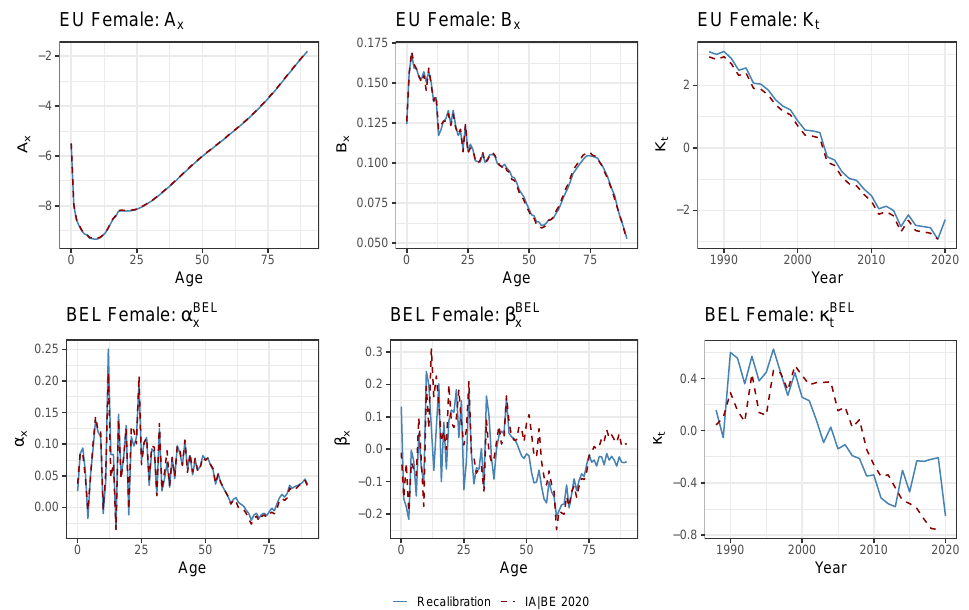
Figure 7. The European and Belgium-specific Li and Lee parameters ˆ A x , ˆ B x , ˆ α x , ˆ β x , ˆ K t and ˆ κ t for females. The blue line corresponds to the Li and Lee model calibrated on data from the years 1988- 2020, with virtually created deaths and exposures for the years 2019–2020. The dark red, dashed line shows the calibrated Li and Lee parameters in the original IA | BE 2020 model (calibration period